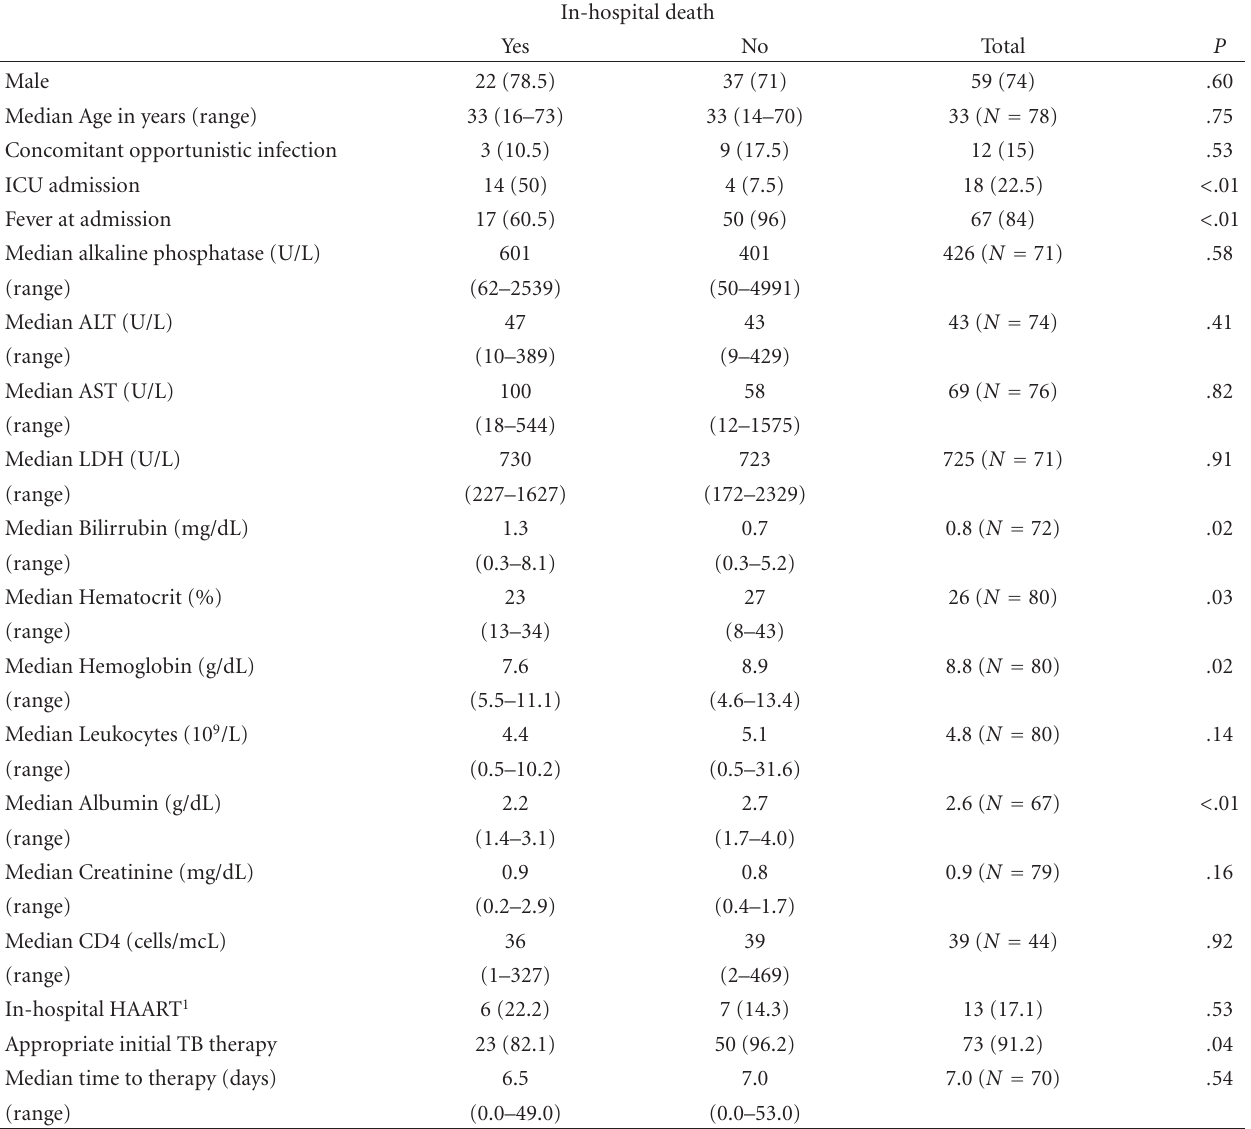
Table 2: In-hospital mortality among HIV-infected patients with disseminated